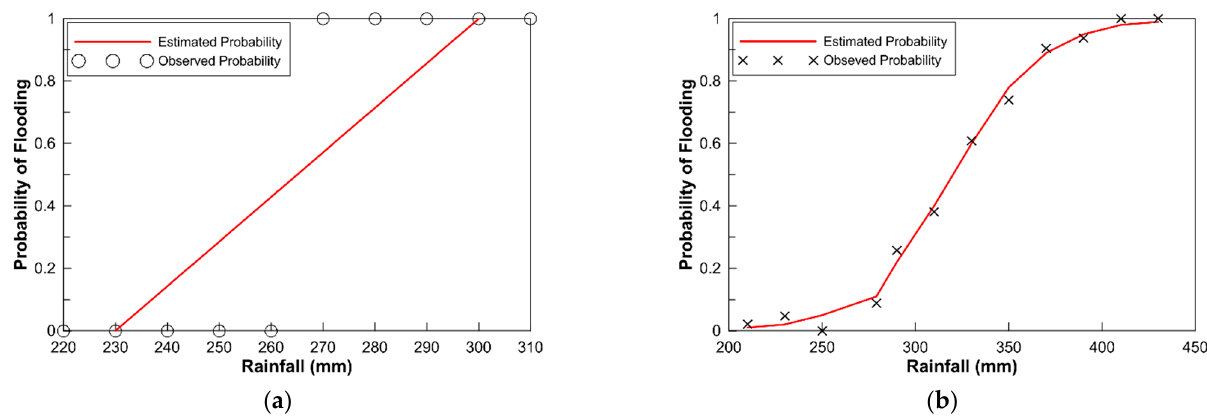
Figure 2. Relationship between rainfall and probability of flooding [21]. ( a ) Linear regression; ( b ) Logistic regression.